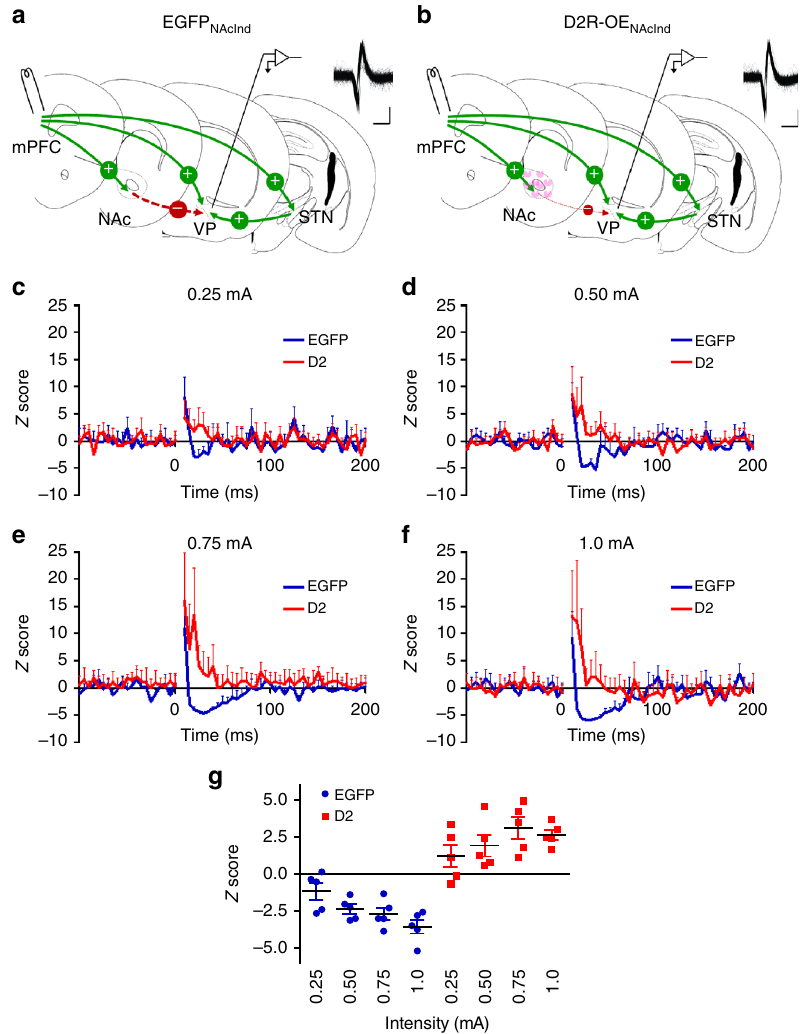
Fig. 5 D2R upregulation is associated with reduced mPFC-evoked inhibition of ventral pallidal neurons in vivo. a , b Schematic depictions of the stimulating electrode in the medial prefrontal cortex (mPFC) and the recording electrode in the VP in anesthetized mice. mPFC stimulation can lead to excitation of VP neurons directly or via the subthalamic nucleus (STN). mPFC stimulation also leads to inhibitory responses in VP by activation of NAc GABAergic projection neurons. Solid green arrows and ( + ) sign depict excitatory projections, while the dotted red arrow and ( – ) sign represent inhibitory projections. Insets, representative VP spike waveforms from recorded cells (overlay of ~500 spikes; scale = 1.0 ms, 0.1 mV) are consistent with those of GABAergic neurons. We hypothesized that, in contrast to EGFP controls ( a ), additional D2Rs (pink) in NAc D2-MSNs would attenuate cortically-evoked inhibition of VP ( b ). c – f Z score transformed peristimulus time histograms (PSTHs) showing mPFC-evoked responses in all recorded VP neurons at different stimulation intensities. Electrical stimulation of the mPFC resulted in an excitation-inhibition response in the VP in the EGFP NAcInd mice. VP neurons in D2R-OE NAcInd mice generally lacked the inhibitory response. g Change in fi ring rate during the 75 ms following mPFC stimulation expressed as a Z score of the pre- stimulation fi ring rate distribution. Basal fi ring rates were not different between the two groups (EGFP NAcInd mice: 8.83[1.67] Hz; D2R-OE NAcInd mice: